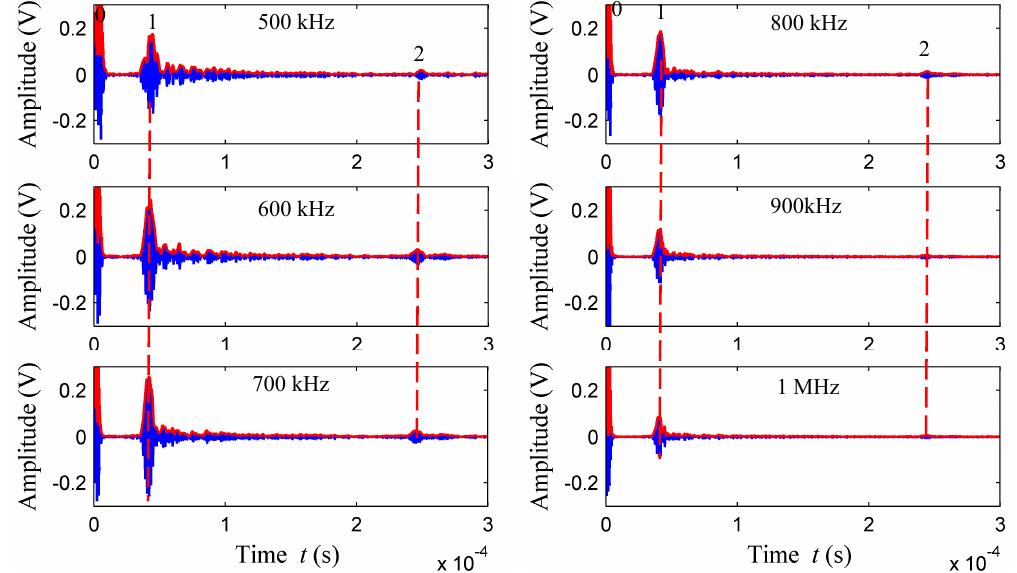
Figure 15. The time domain waveforms for crack defects of thick walled pipe outer wall.